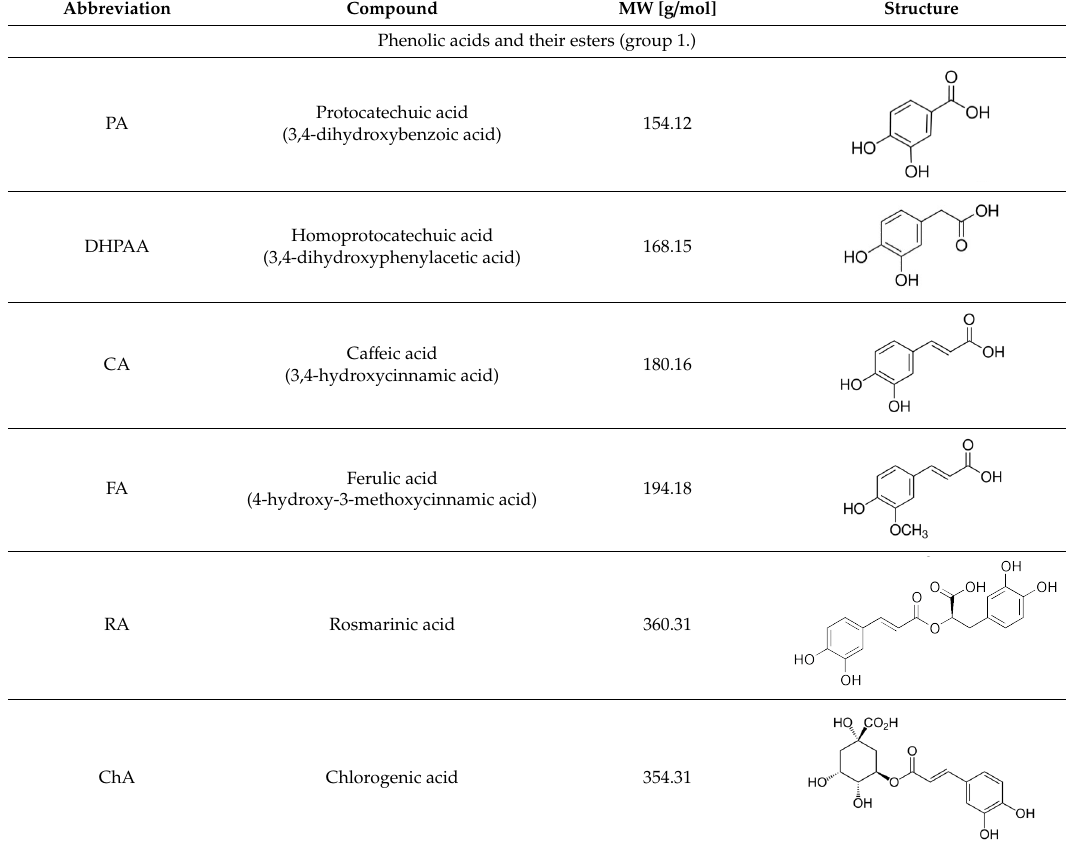
Table 1. Phenolic compounds and reference inhibitors of both glycation and oxidation processes.